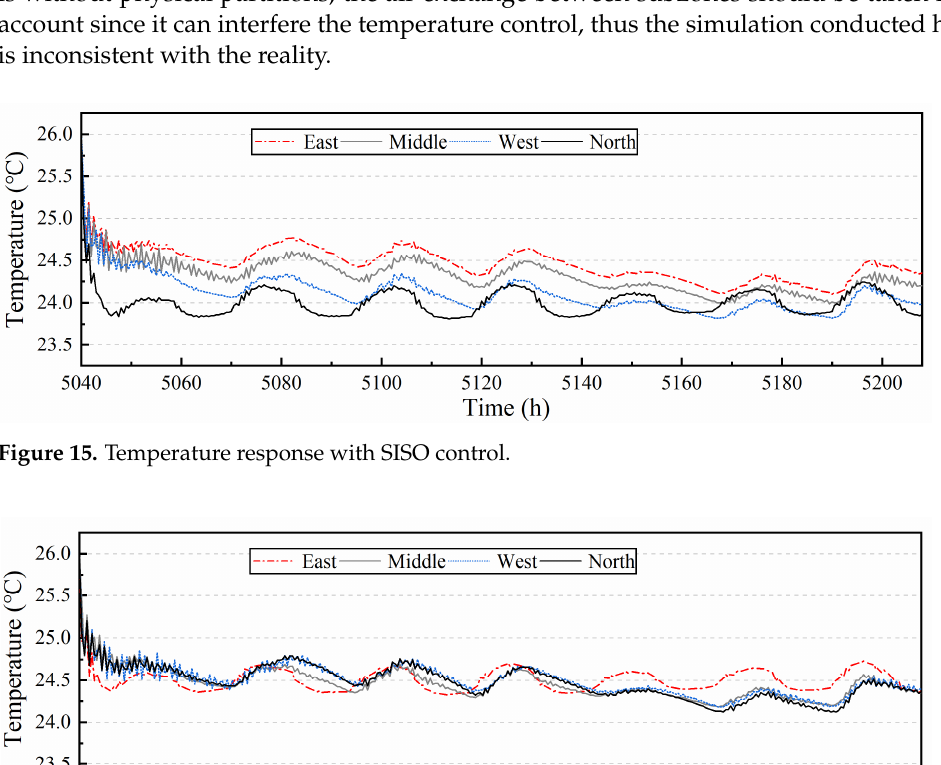
Figure 15. Temperature response with SISO control.